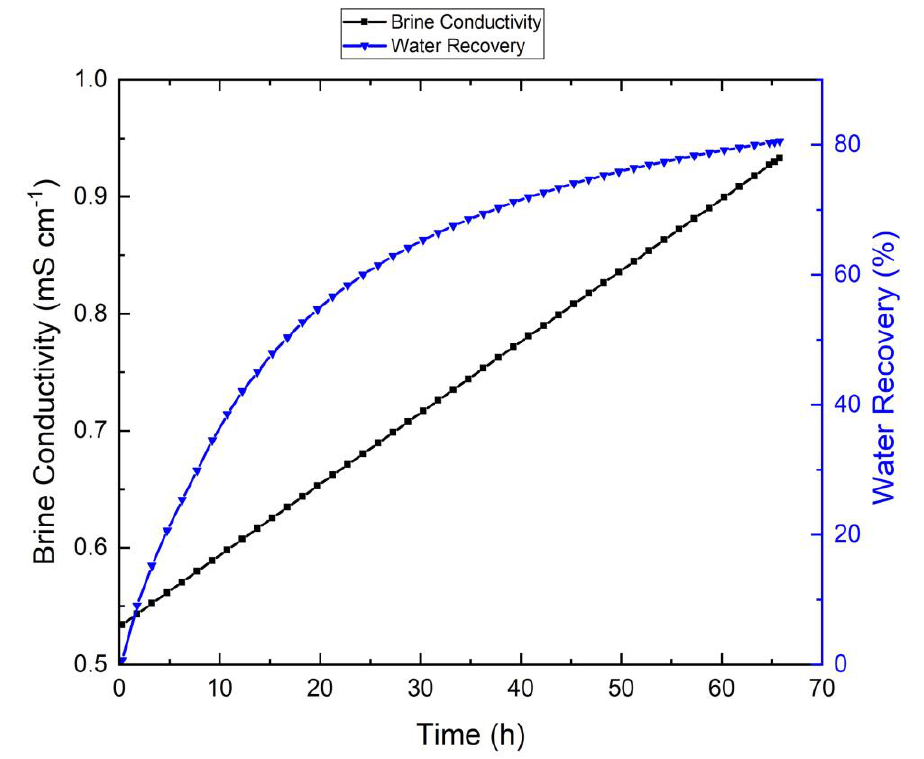
Figure A2. Brine conductivity and water recovery as functions of time for the system with tap water as feed.